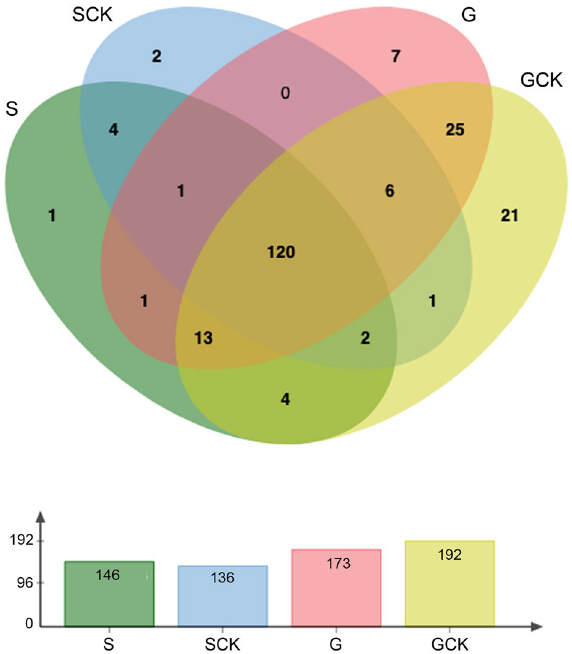
Figure 3. Distribution of the 208 mature miRNAs found in Aedes aegypti saliva and salivary glands. The Venn diagram shows the degree of overlap between miRNAs expressed in the four samples. S (green) and SCK (light blue), saliva from uninfected and CHIKV-infected mosquitoes; G (pink) and GCK (yellow), salivary glands from uninfected and CHIKV-infected mosquitoes. The number of miRNAs found expressed in each sample is shown below the diagram. Venn diagram obtained by the jvenn tool at http:// jvenn. toulo use. inra. fr/ app/ examp le.